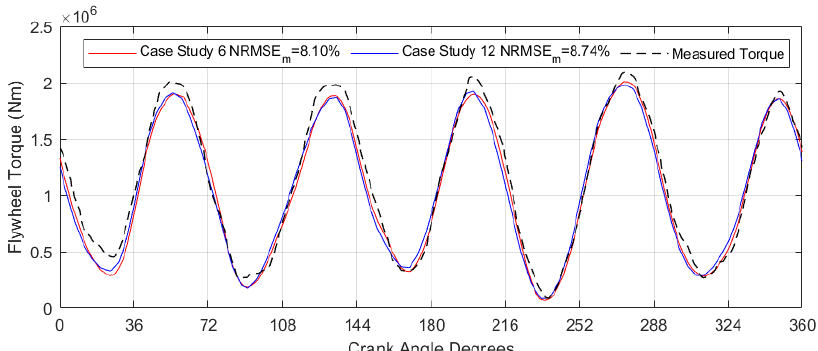
Figure 8. Variable engine friction submodel and variable inertia-speed approach predicted torque (case